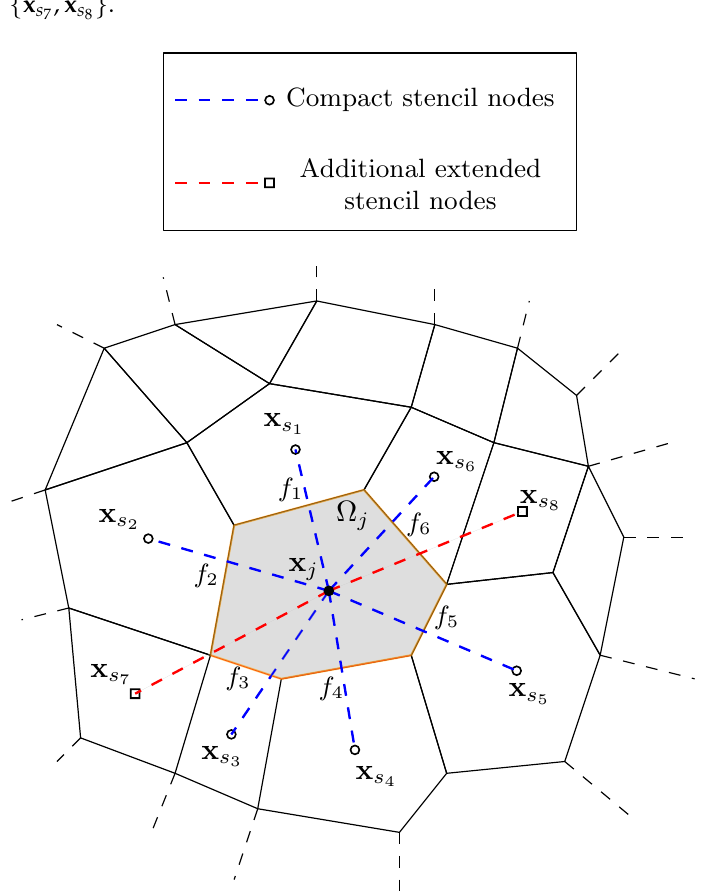
Figure 3. Compact and extended cell